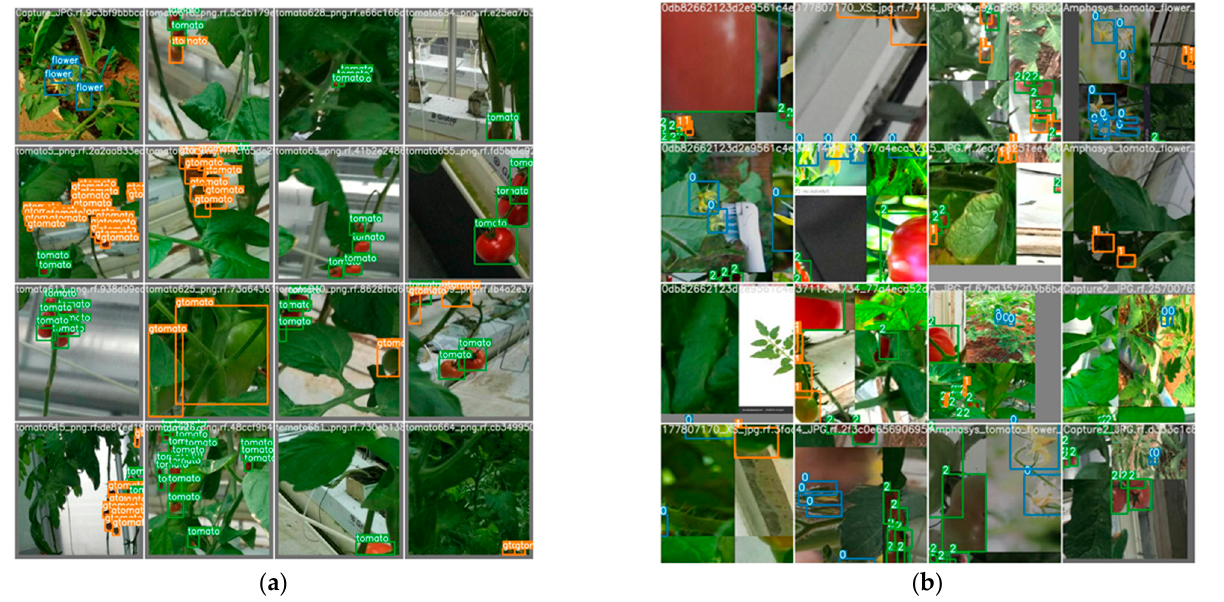
Figure 6. The data set representation, ( a ) Ground Truth Training Data, ( b ) Ground Truth Augmented training data. For augmented data, 0, 1, and 2 labels represent flower, green tomato, and red tomato classes, respectively.